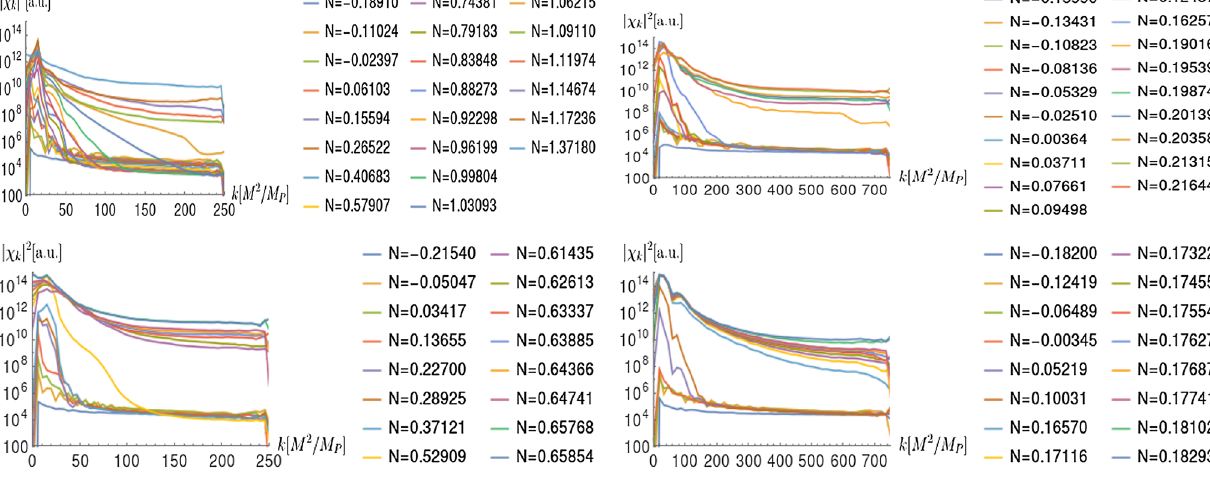
Fig. 13 The power spectrum of the spectator perturbations for n = 1 ,α = 10 − 3 (upper left), n = 1 ,α = 10 − 4 (upper right), n = 1 . 5 ,α = 10 − 3 (lower left), n = 1 . 5 ,α = 10 − 4 (lower right) for different number of e-folds N after the end of inflation. These results were obtained on a lattice with N lattice =